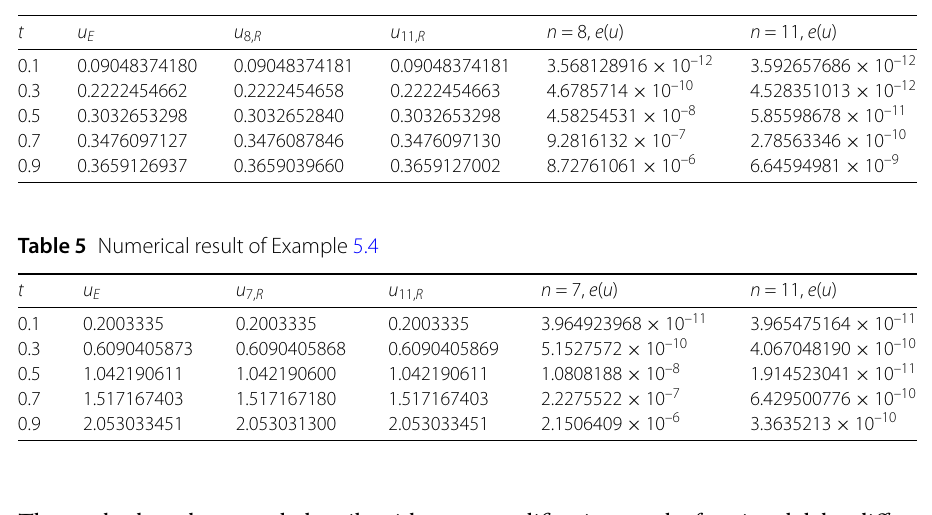
Table 4 Numerical result of Example 5.3